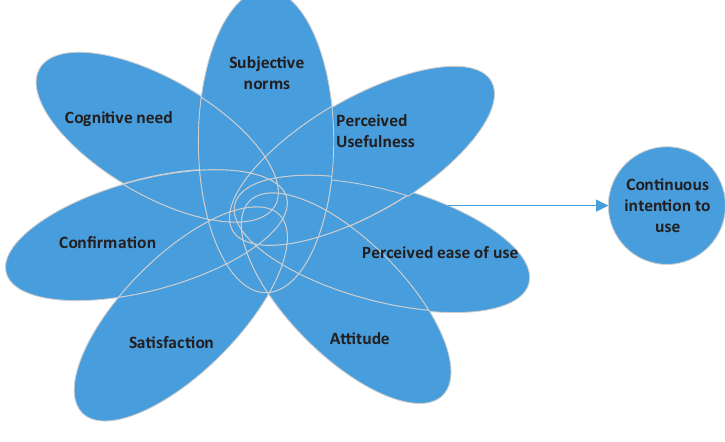
illustrating the conceptual model that explains intention to use